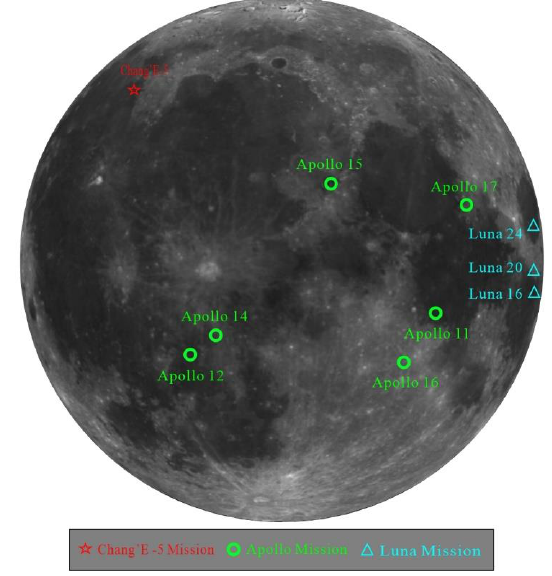
Figure 1. The landing sites of Apollo, Luna, and Chang’E-5 missions. Table 2. The counts of analyzed records collected in this paper from each mission with other